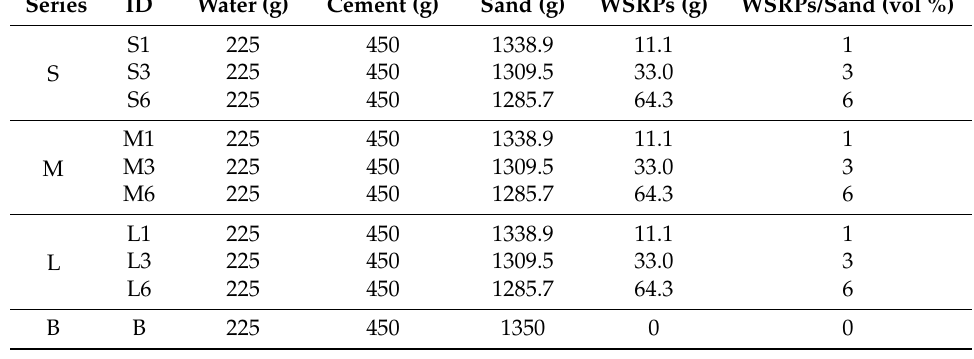
Table 2. Mix content of cement mortar.